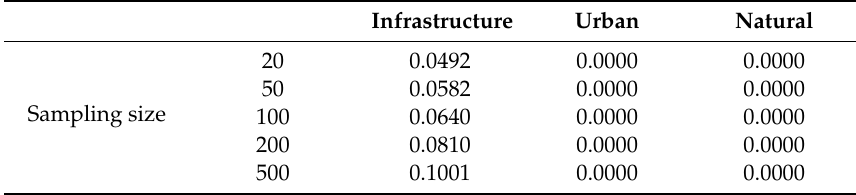
Table 8. Proportion of times that the null hypothesis has been rejected for the QC2 (bias case).